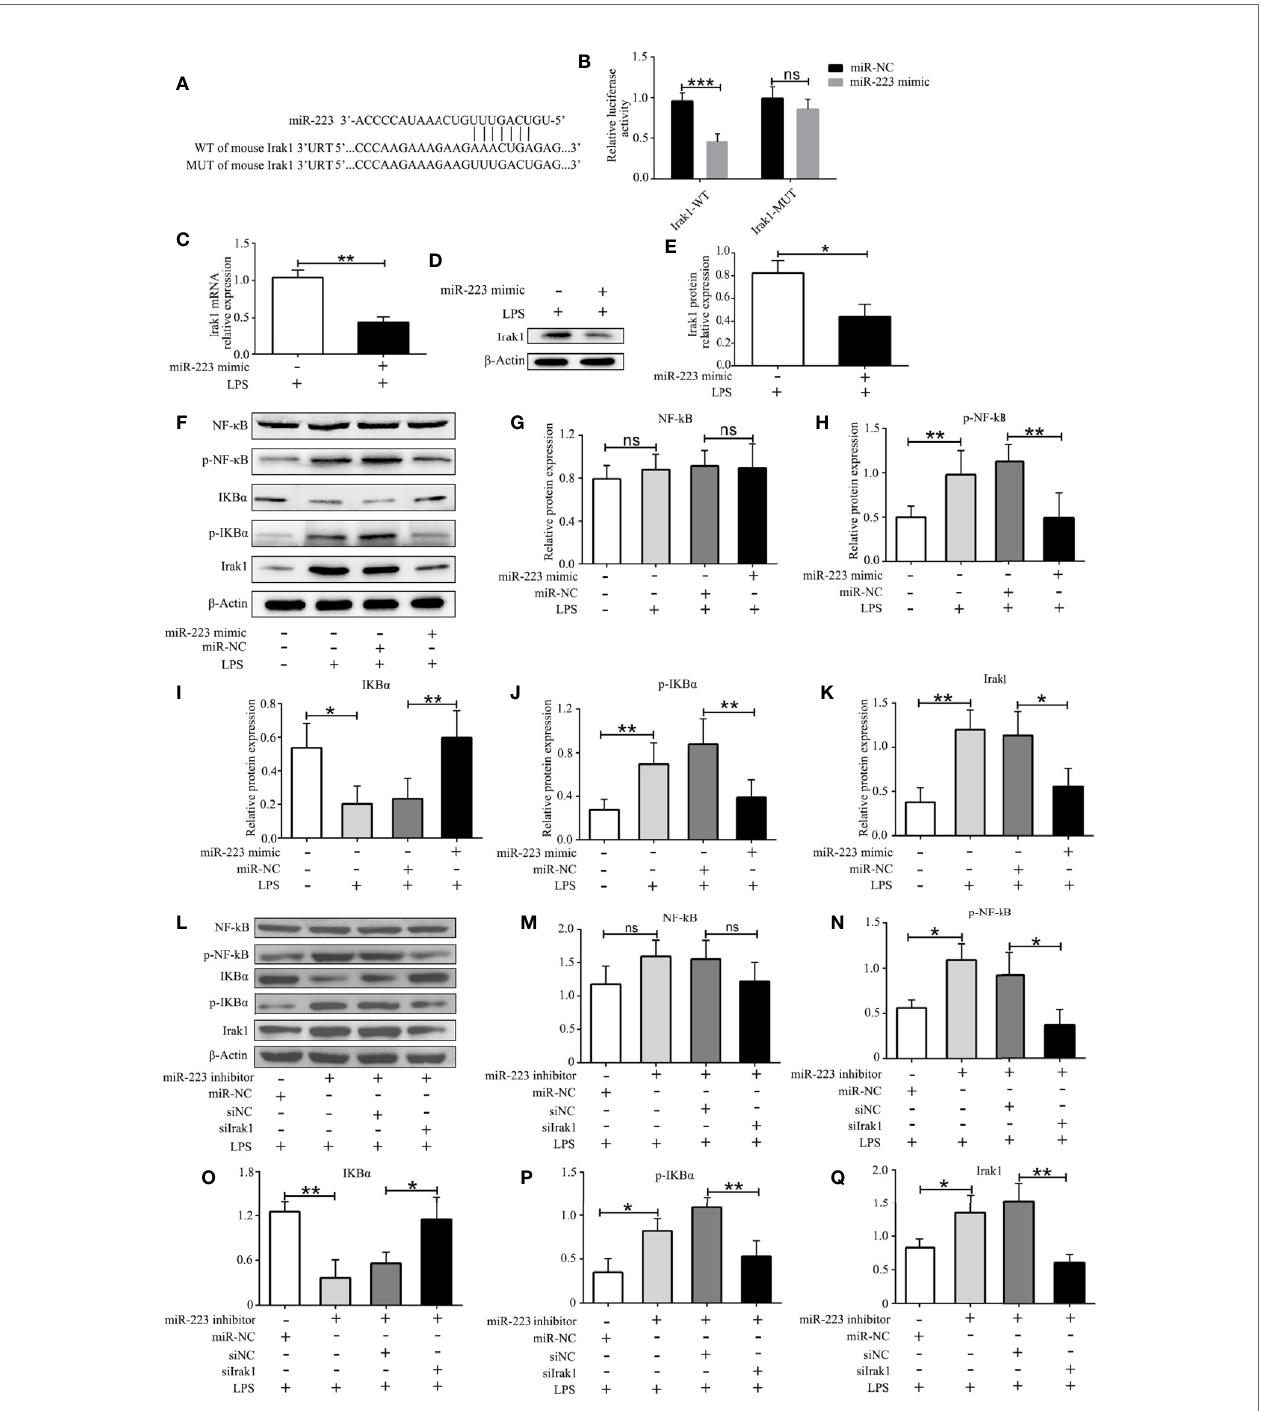
FIGURE 4 | Irak1 is a miR-223 target. (A) Predicted miR-223 binding sites in the Irak1 3 ’ -UTR. (B) Dual-luciferase reporter gene assay. (C, D) Irak1expression was tested by RT-PCR and western blotting. (E) Densitometric analysis of Irak1 in murine BMDCs transfected with a miR-223 mimic or control. (F) Immunoblot analysis of the indicated total and phosphorylated proteins in lysates of imBMDCs transfected with the miR-223 mimic or miR-NC, and then stimulated with LPS (100 ng/ml) for 12 h. (G – K) Densitometric analysis of NF-kB, p-NF-kB, IKB a , p- IKB a , and Irak1 in lysates of imBMDCs transfected with the miR-223 mimic or miR-NC, and then stimulated with LPS (100 ng/ml) for 12 h. (L) Immunoblot analysis of the indicated total and phosphorylated proteins in lysates of imBMDCs transfected with miR-223 inhibitor, miR-NC, siNC, and siIrak1, and then stimulated with LPS (100 ng/ml) for 12 h. (M – Q) Densitometric analysis of NF-kB, p-NF-kB, IKB a , p- IKB a , Irak1 in lysates of imBMDCs transfected with miR-223 inhibitor, miR-NC, siNC, and siIrak1, and then stimulated with LPS (100 ng/ml) for 12 h. Data are presented as mean ± SD and represent three experiments. *P < 0.05; **P < 0.01; ***P < 0.001; ns, not signi fi cant; UTR, untranslated region; WT, wild type; MUT,